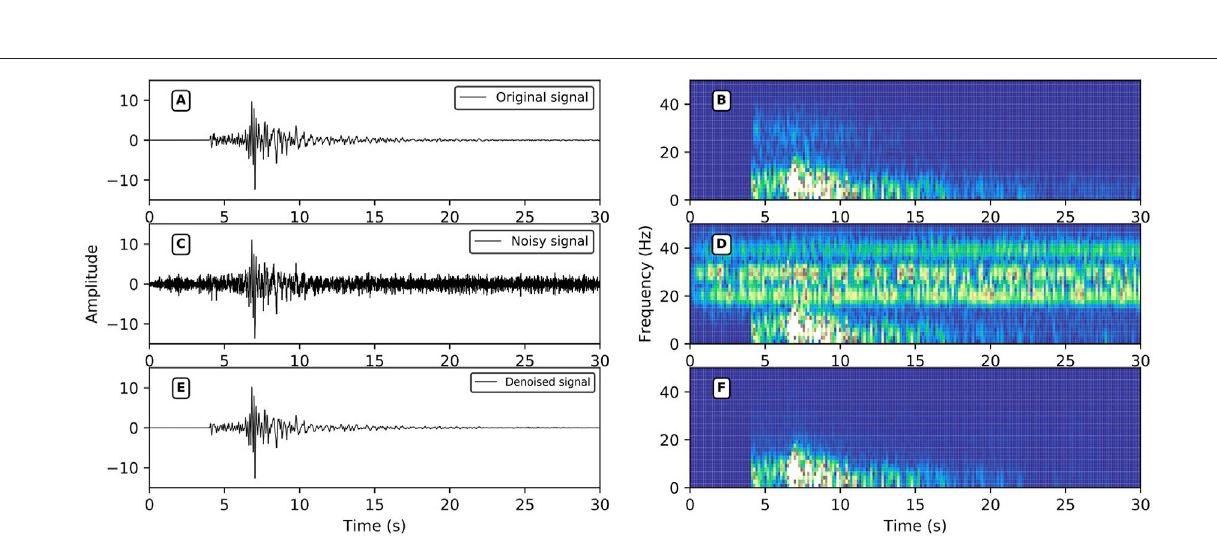
Frontiers in Earth Science |